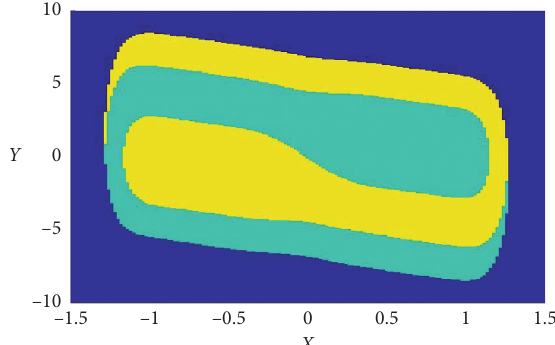
Figure 8: Cross section of the basins of attraction of the two coexisting attractors in the x - y